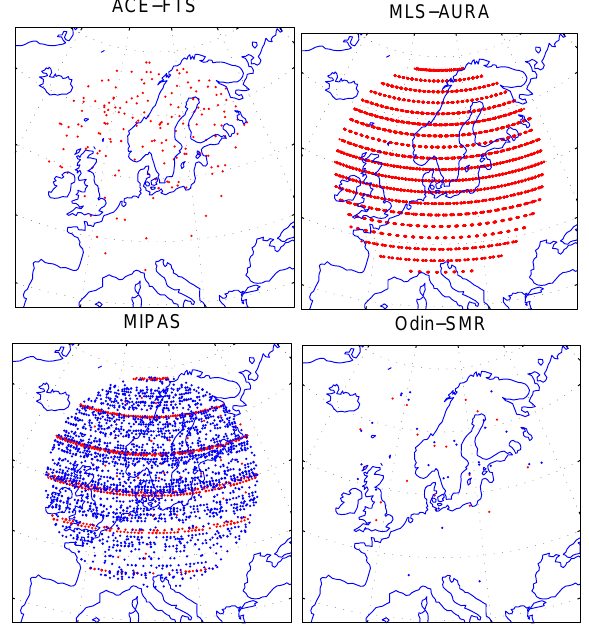
Fig. 8. Satellite (co-location) positions. The dots indicate the satel- lite positions within 1500km radius from OSO, which also ful- fill the PV criteria. In the MIPAS co-location map red/blue dots show (12+13)/(200) data, respectively. In the Odin co-location map red/blue show v225/v021,